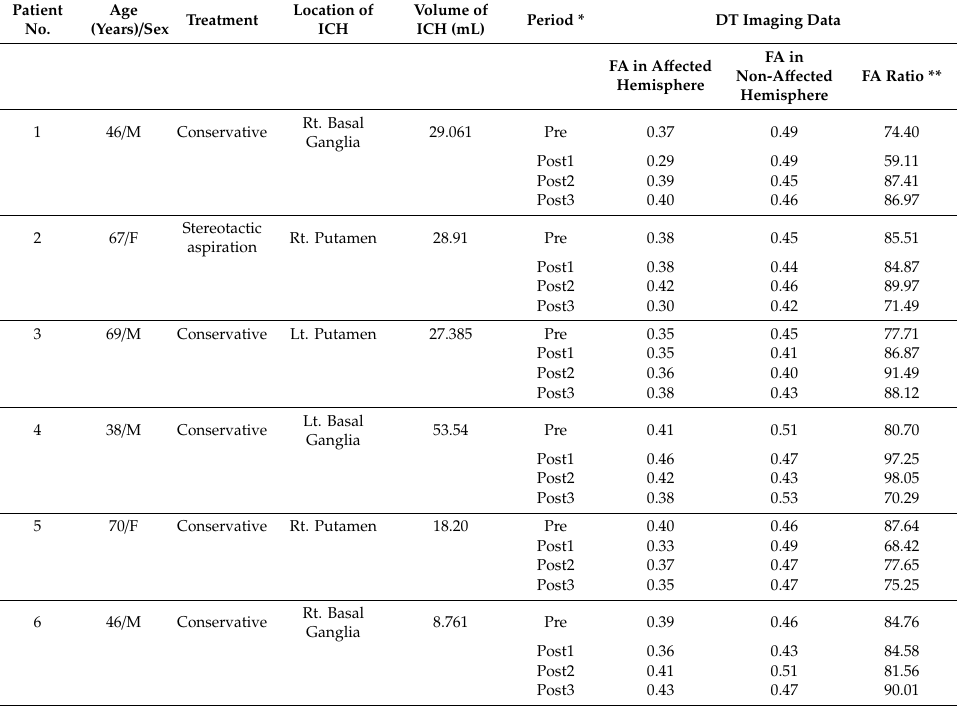
Table 2. Patient characteristics and di ff usion tensor tractography fractional anisotropy values of the poor outcome group. Patient No.